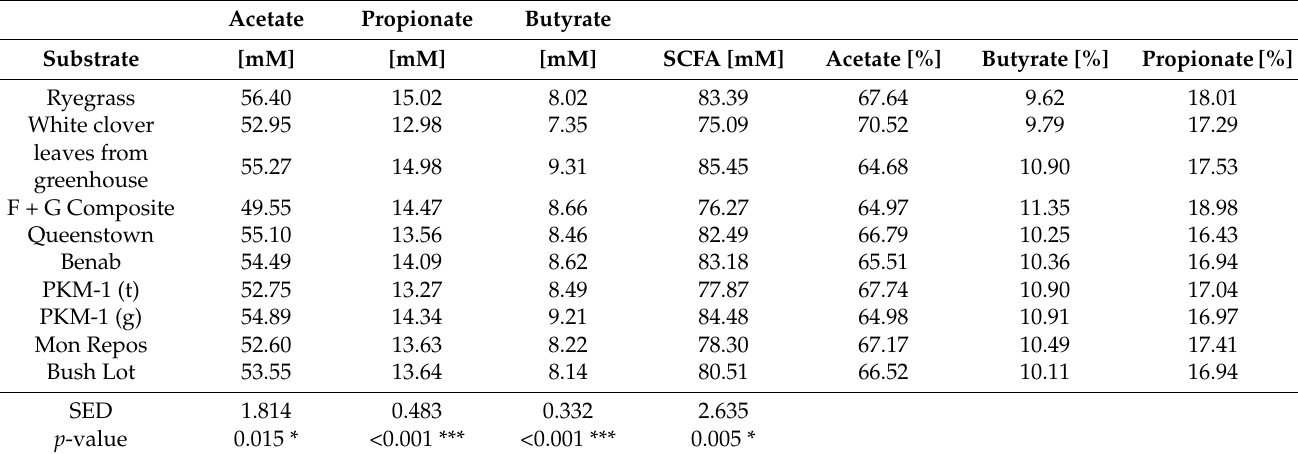
Table 6. Short-chain fatty acids at the end of fermentation for different M. oleifera sources. Acetate, pro- pionate and butyrate are presented along with total short-chain fatty acids. The mean concentration in mM, average standard error of the differences (SED) and p -value are